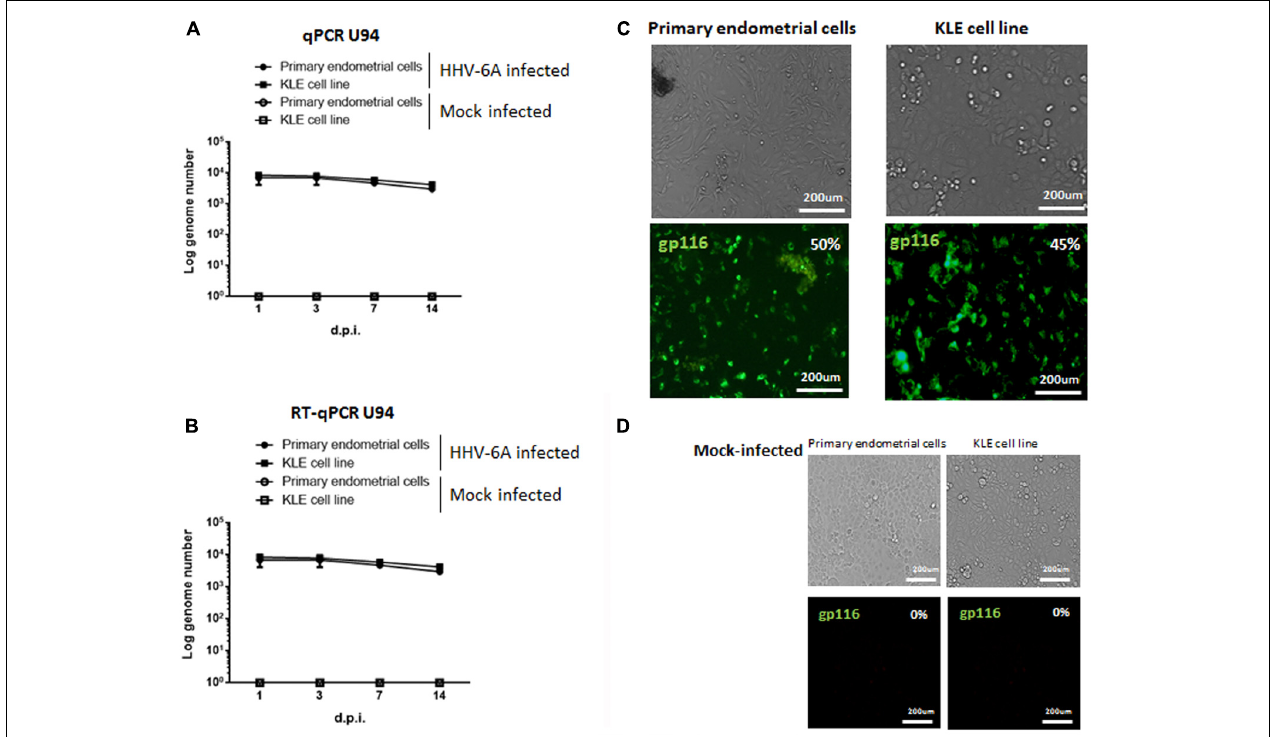
FIGURE 2 | Primary endometrial epithelial cells and KLE cell line (ATCC CRL-1622) were infected with HHV-6A or UV-inactivated (Mock-infected) HHV-6A. The infection was evaluated after 1, 3, 7, and 14 days post infection (d.p.i.). (A) DNA and (B) RNA expression of viral U94 antigen were evaluated by Real time PCR. Results represent the mean copy number ± SD referred to duplicates of 4 independent assays. (C,D) Endometrial epithelial cells were stained for gp116 late viral antigen 7 d.p.i. with HHV-6A (C) or mock (D) . Images were taken in bright field ( upper panels ) or fluorescence ( lower panels ) (Nikon Eclipse TE2000S) equipped with a digital camera. Original magnification 20 ×